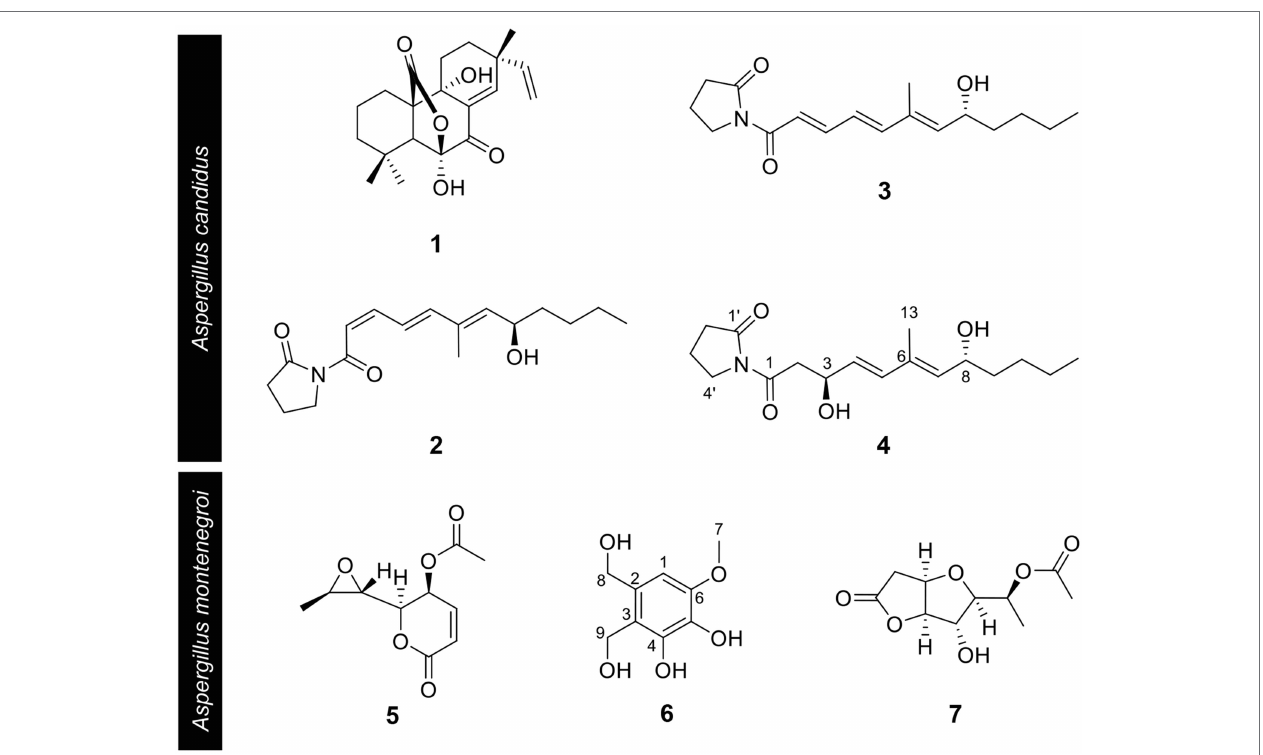
FIGURE 2 | Chemical structures of compounds 1 – 7 isolated from Aspergillus candidus SFC20200425-M11 and Aspergillus montenegroi SFC20200425-M27. Sphaeropsidin A ( 1 ), (R) -formosusin A ( 2 ), ( R )-variotin ( 3 ), and candidusin ( 4 ) were isolated from Aspergillus candidus . Asperlin ( 5 ), montenegrol ( 6 ), and protulactone A ( 7 ) were isolated from A. montenegroi .